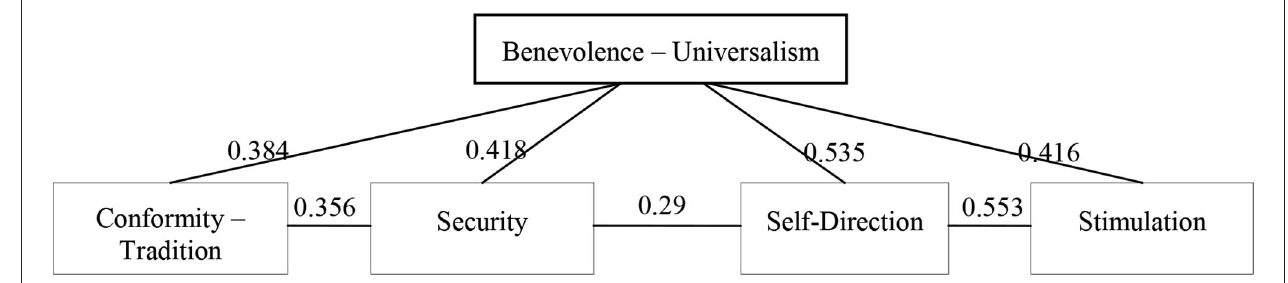
FIGURE 3 | Value indices correlation Pleiades. Pearson correlation, Significance level p <